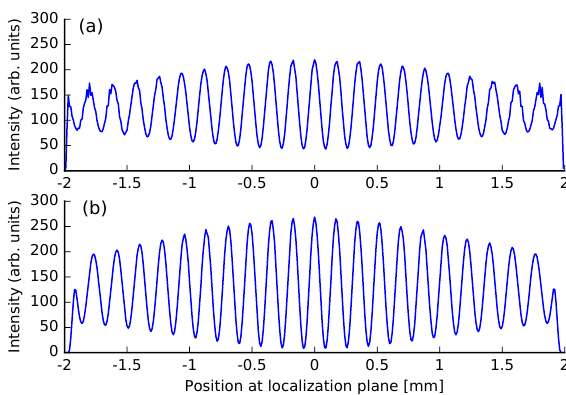
Figure 7. Simulated interferograms for the centre row of the 2-D interferogram (Fig. 6). The upper plot shows the interferogram at the Gaussian focal point and the lower one at a slightly shifted posi- tion, where the foci across the image considering wave aberrations are more compact than at the Gaussian